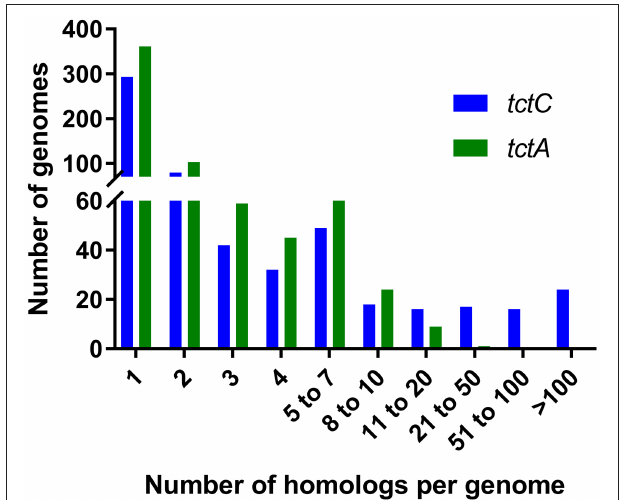
FIGURE 4 | Numbers of genomes containing different ranges of homologs for tctC and tctA .